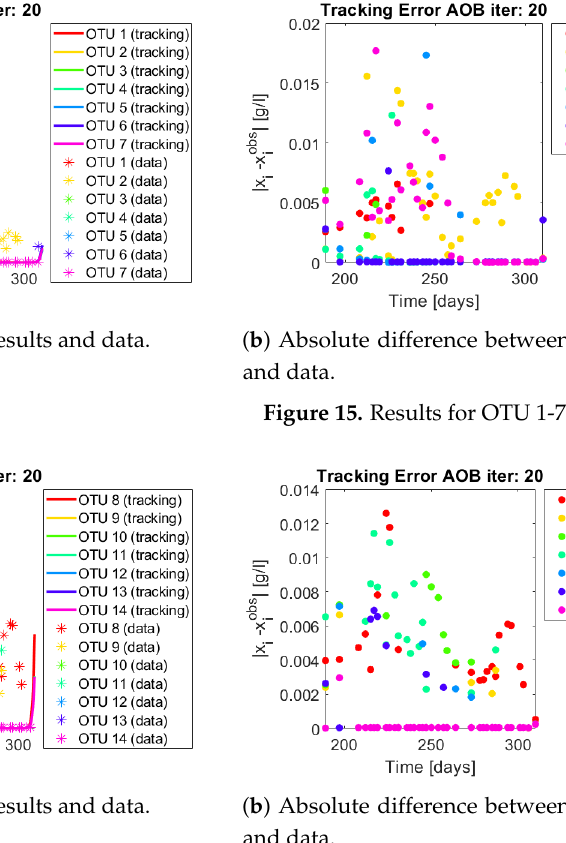
Figure 16. Results for OTU 8-14